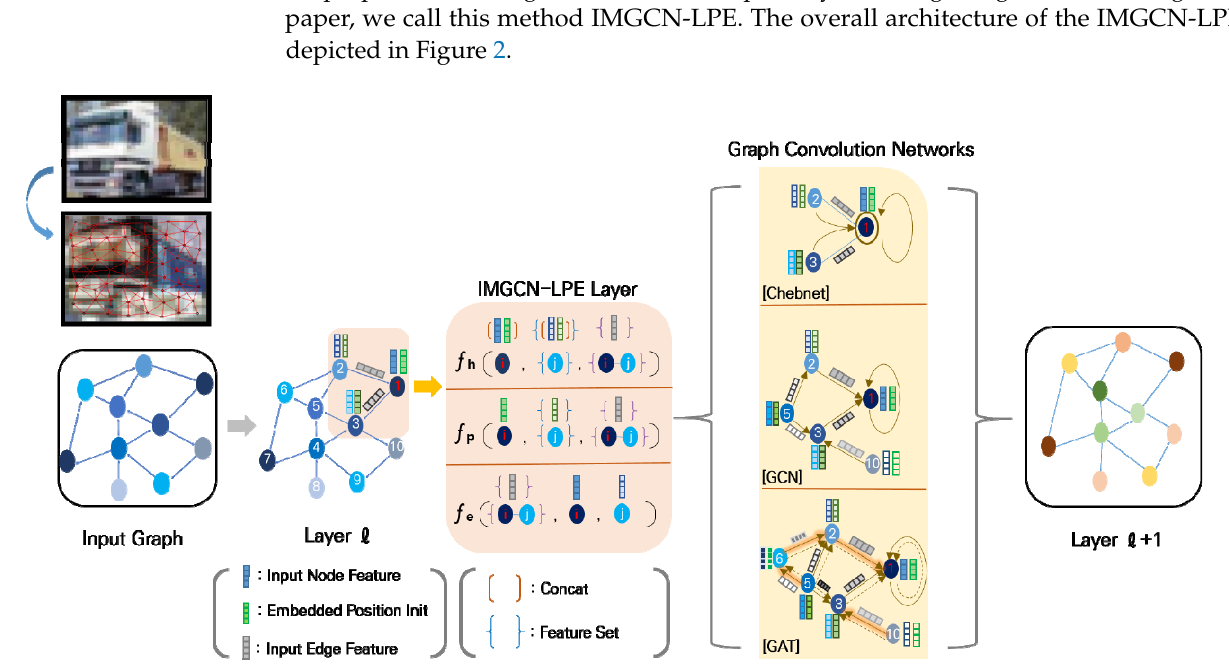
Figure 2. Main architecture of the graph convolutional network with learnable positional embedding applied on images (IMGCN-LPE).